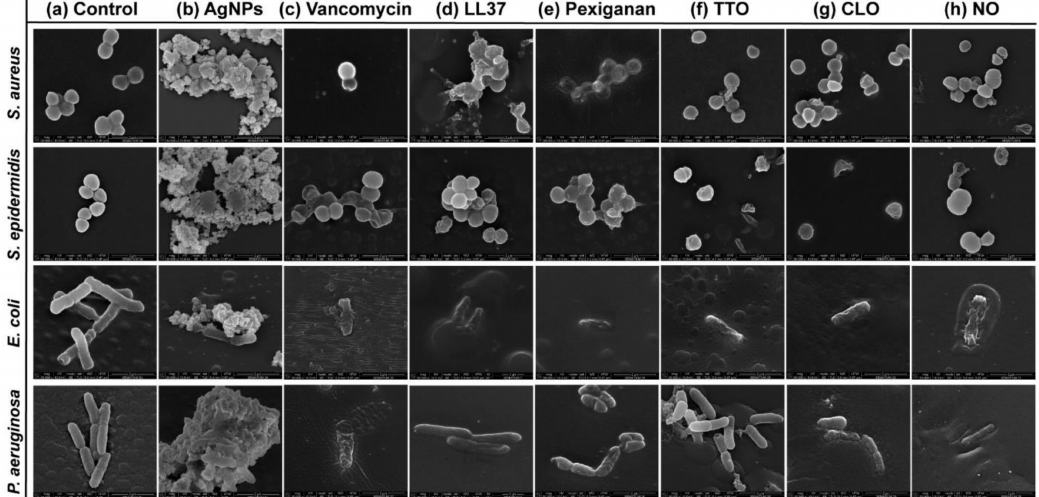
Figure 3. Micrographs of S. aureus (Sa), S. epidermidis (Se), E. coli (Ec) and P. aeruginosa (Pa) bacteria untreated (control) and treated with the selected antibacterial agents, at the smallest tested concentration just before establishing the MIC value. Concentrations were defined at 2000 µ g / mL in Sa, Se and Ec and 625 µ g / mL in Pa for AgNPs; 3.9 µ g / mL in Sa and Se and 500 µ g / mL in Ec and Pa for vancomycin; 250 µ g / mL in Sa and Se, 62.5 µ g / mL in Ec and 125 µ g / mL in Pa for LL37; 15.7 µ g / mL in Sa and Pa, 3.9 µ g / mL in Se and 31.3 µ g / mL in Pa for pexiganan; 33.6 µ g / mL in Sa, 89.5 µ g / mL in Se, 16.8 µ g / mL in Ec and 134.3 µ g / mL in Pa for TTO; 15.7 µ g / mL in Sa and Se, 9.9 µ g / mL in Ec and 19.7 µ g / mL in Pa for CLO, and 68.5 µ g / mL in Sa and Ec, 91.3 µ g / mL in Se and 182.6 µ g / mL in Pa for NO. These concentrations allowed for live and dead cells to be observed simultaneously, with morphological di ff erences being more easily